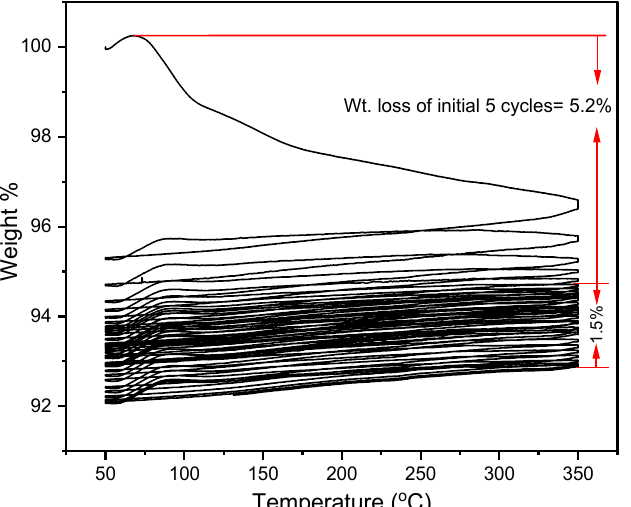
Figure 5. Weight loss vs. temperature plot of chosen salt composition (32 mol% LiCl-68 mol% LiOH) for 30 cycles.